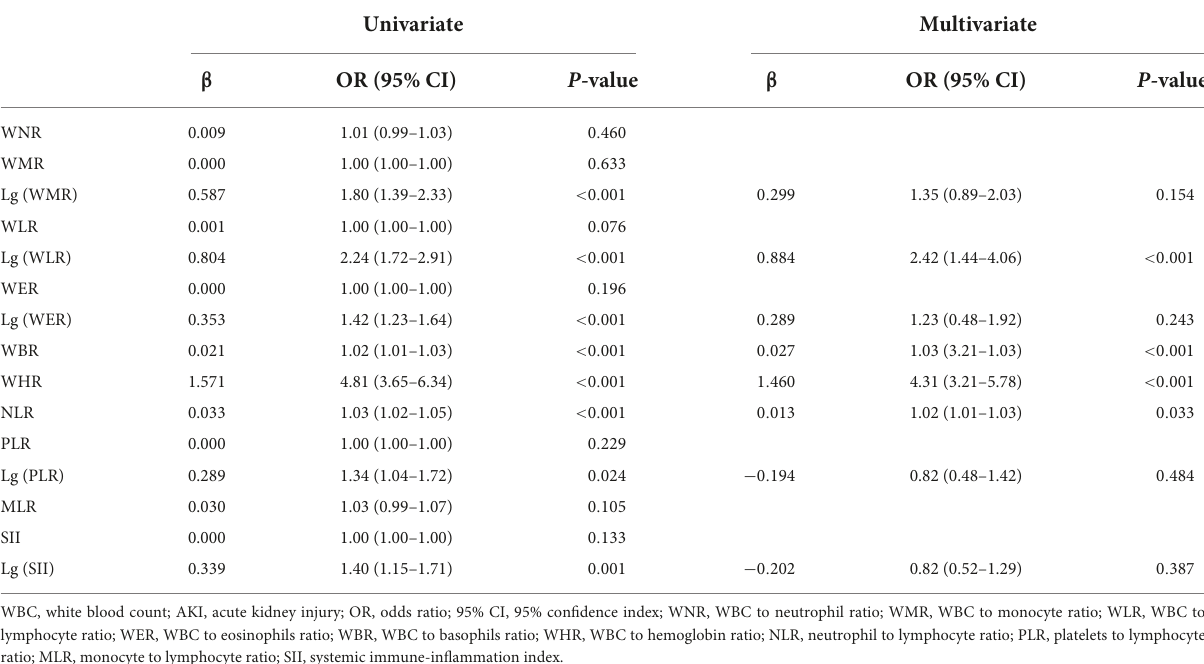
of diuretic use, increased weight, SOFA, OASIS, APS III, HAS- BLED scores, lower MAP, and higher heart rate in both the training and validation sets ( P < 0.05 for all comparisons, Table 1 ). Moreover, patients who developed AKI had markedly